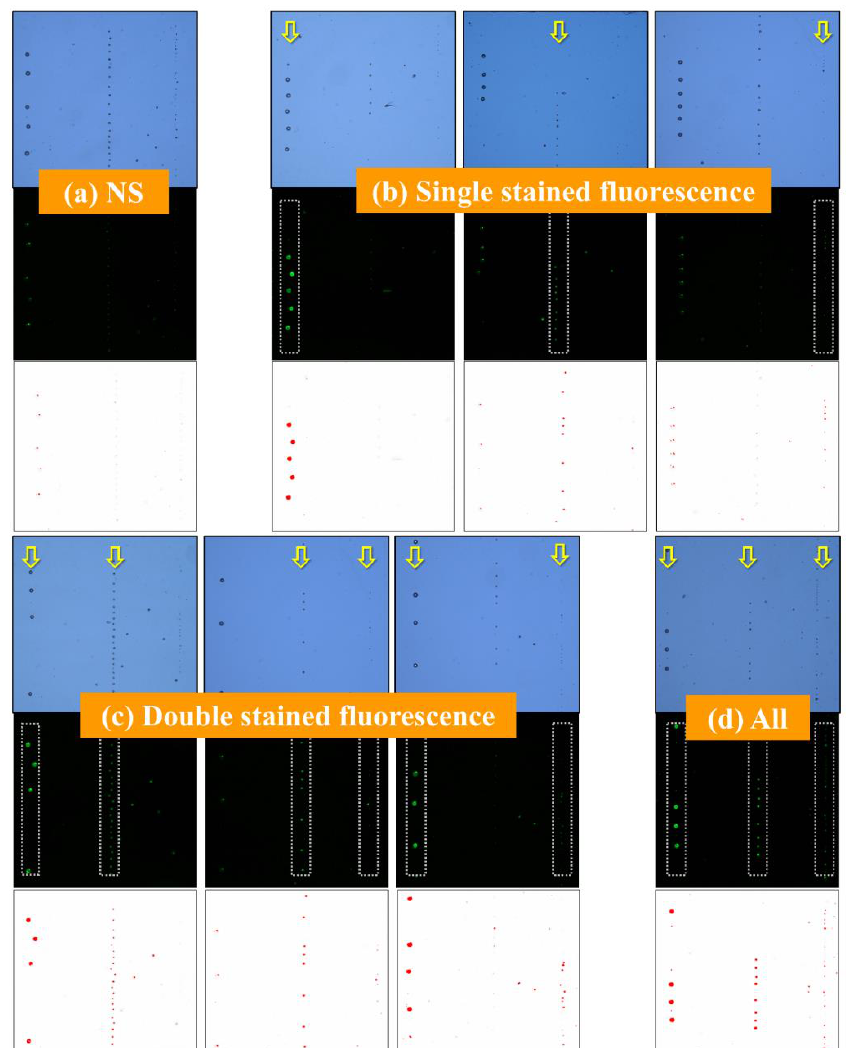
Figure 6. Comparison of optical and fluorescence images, and images filtered by ImageJ software with a detection threshold of 10 for magnetic beads mixed with three different diameters and stained with a ratio of the primary and secondary antibody of 1:4, including ( a ) 0-, ( b ) 1-, ( c ) 2-, and ( d ) 3-stained groups with different diameters for all combinations. It can be clearly seen that three groups with different diameters were easily separated in light images, and only the labeled groups can be observed in fluorescence images.